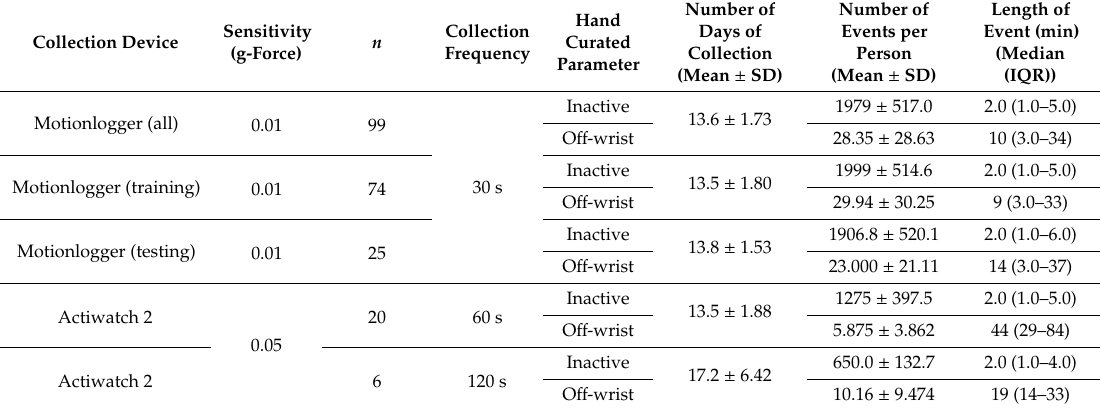
Table 1. Overview of inactive and o ff -wrist parameters from the Motionlogger and Actiwatch 2 devices. IQR: interquartile range, SD: standard